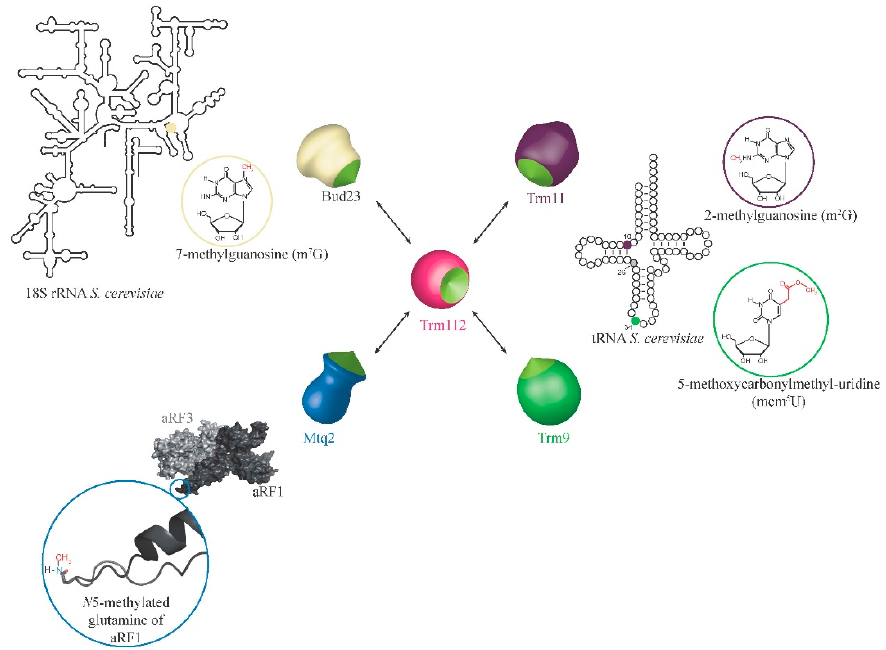
Figure 2. Schematic representation of the Trm112 ‐ methyltransferase ( MTase) interaction network and of the substrates of these complexes. The surface representation of the aRF1 ‐ aRF3 complex from Aeropyrum pernix archeon was generated using PDB Code 3VMF [25]. Positions 10, 26 and 34 on a tRNA molecule are shown in purple, grey and green, respectively. The position of G 1575 on 18S rRNA is shown as a beige sphere. The color code used to depict the various partners will be used in all figures of this review.